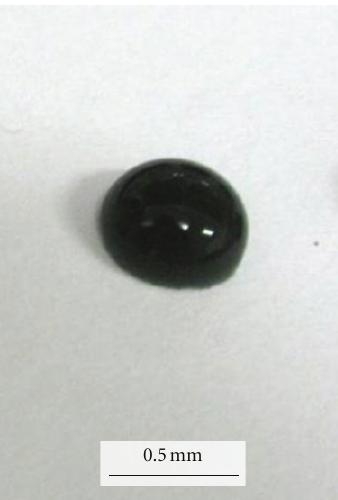
Figure 4: Appearance of CNT dispersion with catechin on paper 10 seconds after being dropped. Dispersion did not penetrate the paper.